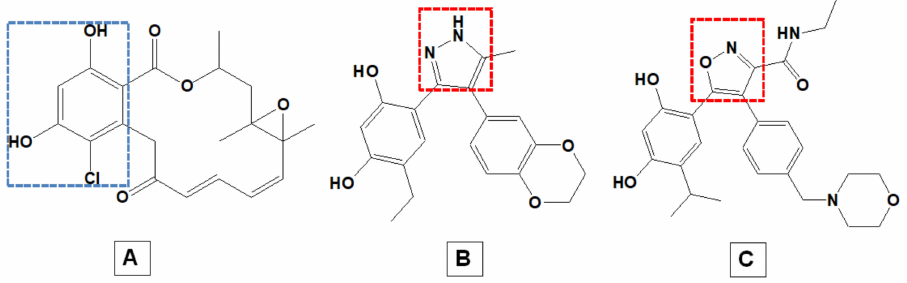
Figure 3. Structural representation of Hsp90 inhibitors: ( A ) RD, ( B ) CCT018159 and ( C ) NVP. Areas highlighted—blue: resorcinol ring and red: isoxazole sca ff